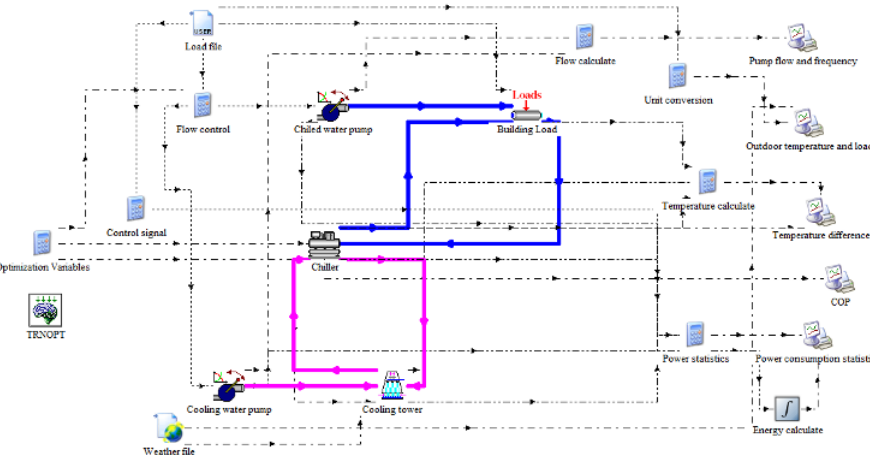
Fig. 3. TRNSYS refrigeration system